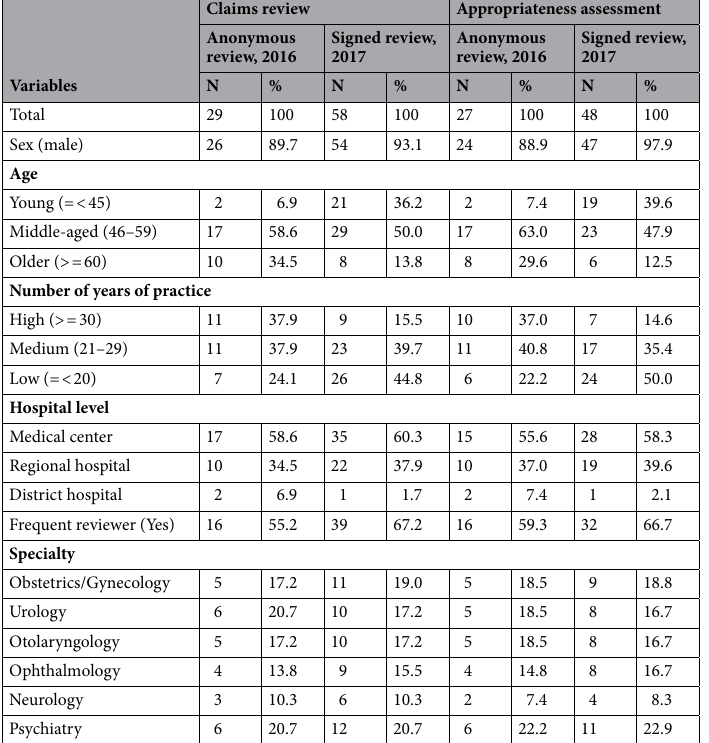
Table 1. Characteristics of the claims reviewers under the Taiwanese National Health Insurance scheme in this